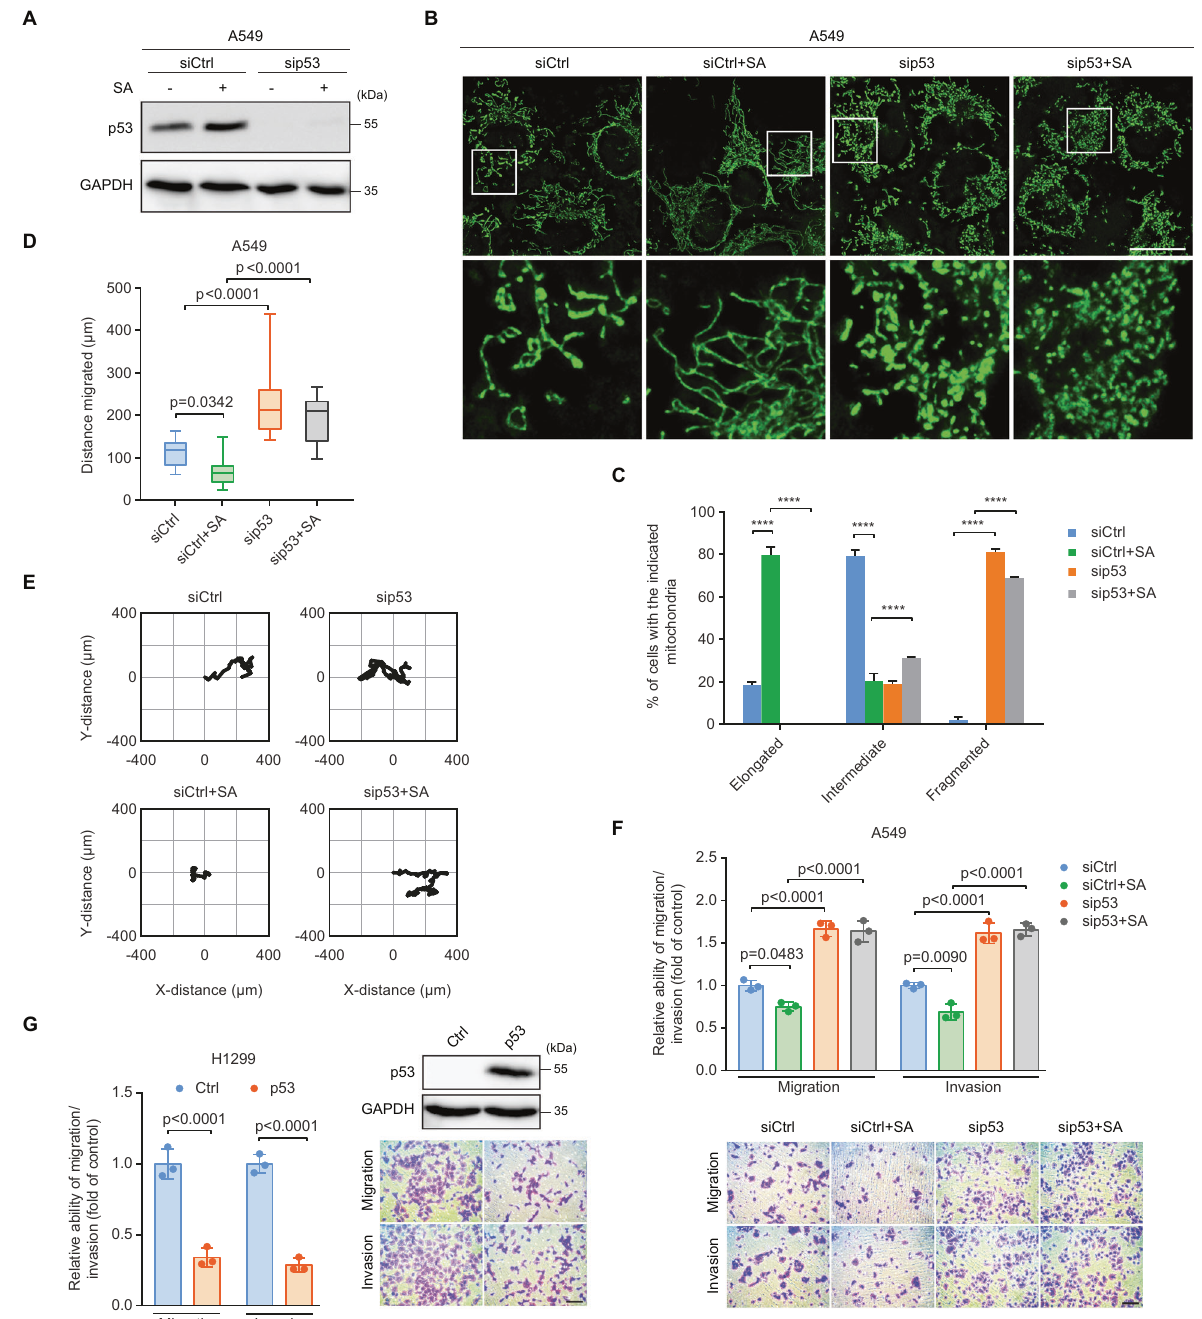
Fig. 3 p53 elevation promotes mitochondrial elongation accompanied by attenuated invasive cell migration. A Immunoblot of p53 in siCtrl and sip53 A549 cells with and without 20 µM SA treatment for 24 h. GAPDH was used as a loading control. Representative images ( B ) and quanti fi cation ( C ) of mitochondrial morphology in siCtrl ( n = 223), siCtrl + SA ( n = 211), sip53 ( n = 205), and sip53 + SA ( n = 218) A549 cells. Boxed regions in ( B ) are shown enlarged in the bottom panels. Scale bar: 20 µm. Migration distance ( D ) and representative trajectories ( E ) of siCtrl ( n = 29), siCtrl + SA ( n = 17), sip53 ( n = 13), and sip53 + SA ( n = 15) A549 cells. Transwell assays for ( F ) siCtrl, siCtrl + SA, sip53, and sip53 + SA A549 cells or ( G ) control (Ctrl) and p53-overexpressing (p53) H1299 cells. Scale bar: 100 µm. Error bars represent mean ± SD. Data were analyzed by one-way ANOVA with Tukey ’ s multiple comparisons test. ****p < proteins relevant to mTORC1 signaling, including the phosphor- control mitochondrial morphology by modulating the phosphor- ylations of mTOR S2448, 4E-BP1 S65, and S6K1 (p70 S6K) T389 ylation of S616 on Drp1. were decreased following SA-stimulated endogenous p53 expres- Reportedly, mTORC1 phosphorylates 4E-BPs to enable MTFP1 sion in A549 cells. p53 depletion enhanced MTFP1 protein levels translation, thereby stimulating Drp1-mediated mitochondrial fi ssion [7]. In agreement with the Drp1 S616 phosphorylation and mTORC1 activity in both untreated and SA-treated cells (Fig. 4A). Furthermore, elevated p53 expression by SA also hampered and mitochondrial fi ssion activity, the levels of MTFP1 and